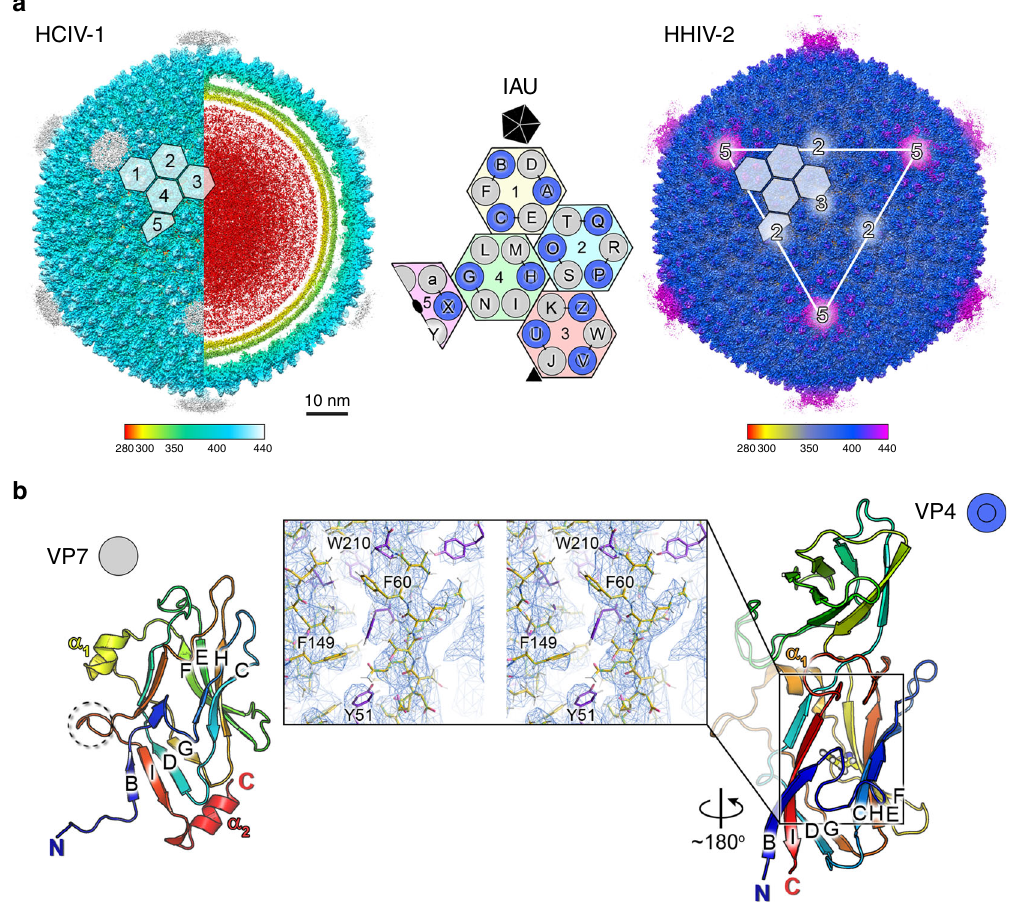
Fig. 1 Cryo-EM density maps of HCIV-1 and HHIV-2 and MCPs. a Overall view of cryo-EM density maps of HCIV-1 (left) and HHIV-2 (right) color-coded by distance from the center (legend below). HCIV-1 is rendered to display the capsid shell (left-half) and the particle interior (right-half), genome in red and inner and outer membrane lea fl ets in yellow and yellow-lime (vertex complexes have been omitted, see Methods and Supplementary Figures 7 and 8). White-transparent hexagons on top of the capsid densities mark the capsomers (numbered in HCIV-1 Nos. 1 – 5) forming the icosahedral asymmetric unit (IAU); the white triangle and numbers on HHIV-2 surface mark a facet of the virion and the icosahedral symmetry axes, respectively. At the center, schematic of the capsomers organization with the three-tower capsomers (No. 1, light-yellow; No. 2, cyan; No. 3, pink), composed of three copies of MCP VP4 (blue circles) and three copies of MCP VP7 (light-gray circles) and with the two-tower capsomers (No. 4, light-green; No. 5, light-magenta; the latter sitting on the icosahedral two-fold axis) composed of two copies of VP4 and four copies of VP7; the fi ve triangles composing the black pentagon represents the fi ve copies of the penton protein plugging the vertices. Characters (A – X and a) identify each MCP subunit within the IAU and black short-lines joining the circles identify the VP7 – VP4 heterodimers (see Fig. 2). b Cartoon representation of the HCIV-1 MCPs VP7 (left) with dashed-circle marking the loop with residues 149 – 154 [also marked in Fig. 2] and VP4 (right) with residue F149 colored in yellow and represented as stick; inset, stereoview of the region marked by a black rectangle with the VP4 atomic model (as stick and differently colored) fi tted into the corresponding 3.7 Å resolution density map (blue mesh contoured at ∼ 3 σ in COOT 26 ); some residues including F149 have been